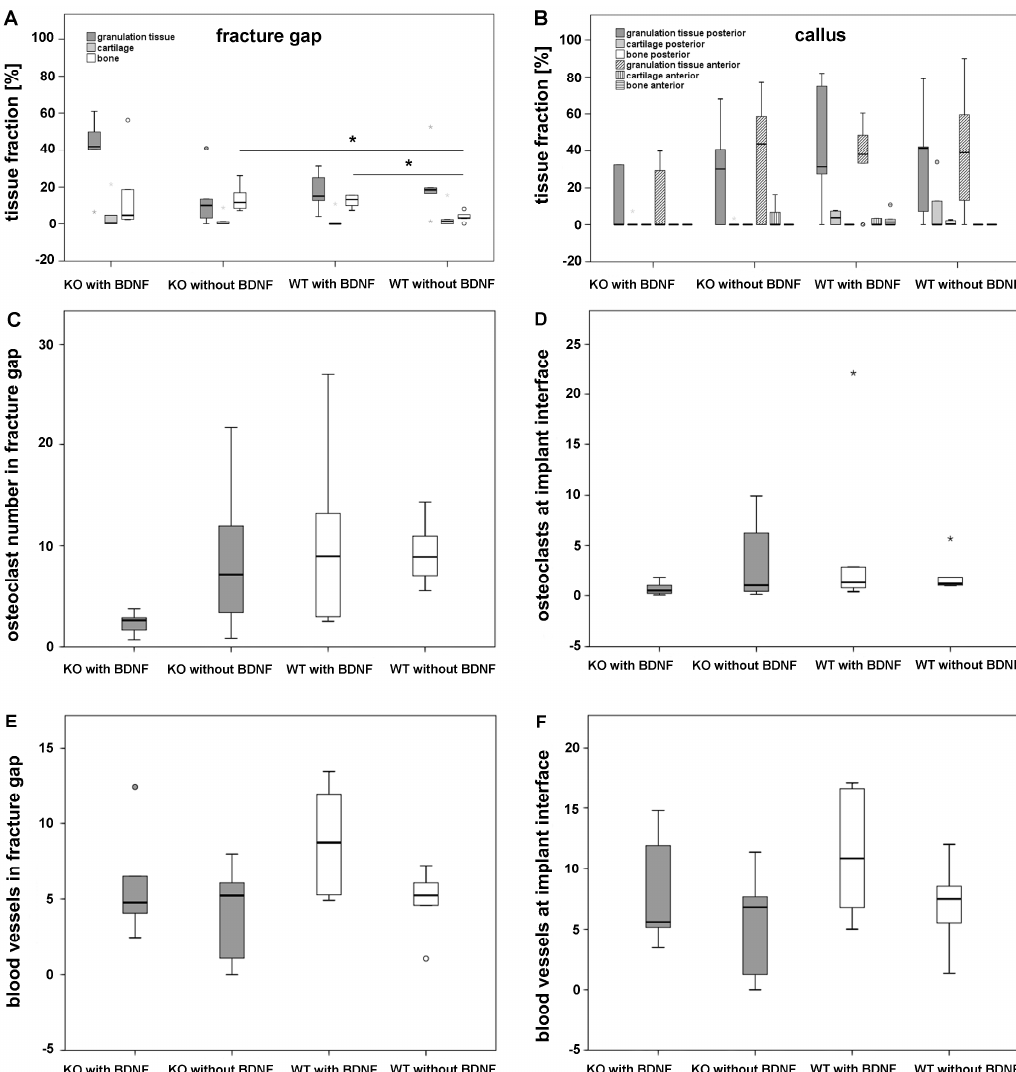
Figure 4. Histomorphometrical analysis: fraction of granulation tissue, cartilage and bone in fracture gap ( A ) and in callus, the dotted line represents boxplots indicating a value of zero ( B ), osteoclast numbers within the fracture gap ( C ) and at implant interface ( D ), number of blood vessels in fracture gap ( E ) and at implant interface ( F ). The grey and white circles indicate outliers. The grey * indicate extreme outliers. The black * illustrate statistically significant differences with a likelihood of p ≤ 0.05.